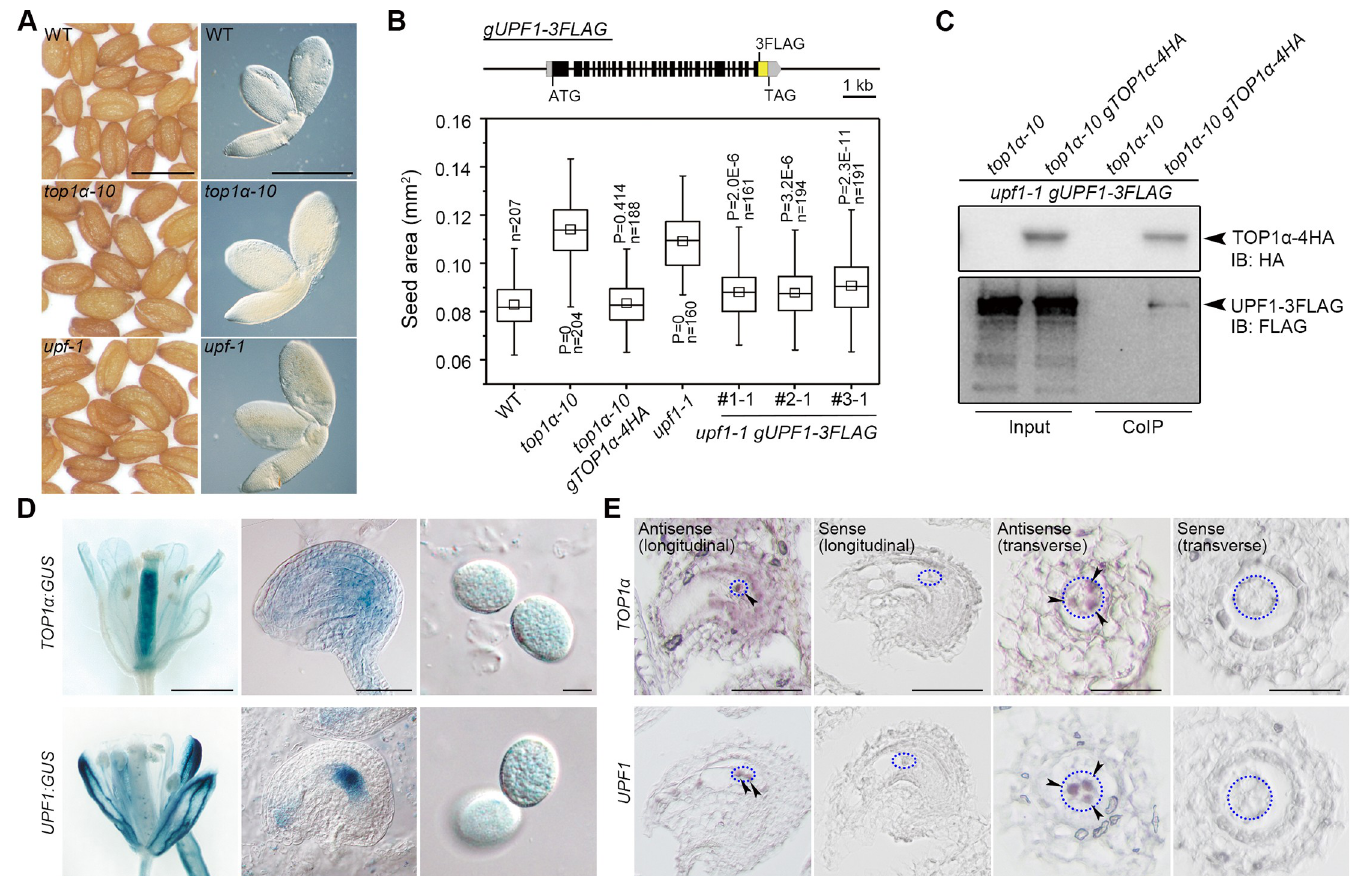
Fig 1. TOP1 α and UPF1 regulate seed size and interact in the nucleus. (A) top1 α -10 and upf1-1 produce larger seeds than WT. Left panels, mature seeds; right panels, mature embryos. Scale bars, 0.5 mm. (B) Seed sizes of top1 α -10 and upf1-1 are rescued by correspondent genomic fragments. Upper panel: schematic diagram of the gUPF1-3FLAG construct. Lower panel: seed sizes of different genetic backgrounds. P values were determined by two-tailed Mann-Whitney U-test compared to WT. (C) In vivo interaction between TOP1 α and UPF1 shown by CoIP. Nuclear protein extracts from pistils of the specified genotypes were immunoprecipitated by anti-HA antibody. The input and CoIP proteins were detected by anti-HA (upper panel) and anti-FLAG antibody (lower panel), respectively. (D) Representative GUS staining of TOP1 α : GUS and UPF1 : GUS in opening flowers (left panels), ovules (middle panels), and pollen grains (right panels). Scale bars, 1 mm, 50 μ m, 10 μ m from left to right. (E) In situ localization of TOP1 α and UPF1 mRNA expression in ovules. Blue dotted ellipses indicate the regions where antipodal cells are located, and arrowheads indicate antipodal cells with signals. Scale bars, 50 μ m, 50 μ m, 25 μ m, and 25 μ m from left to right. The data underlying this figure are included in S1 Data and S1 Raw Images. CoIP, co-immunoprecipitation; GUS, β -glucuronidase; HA, hemagglutinin; n, number of seeds examined; IB, immunoblotting; WT, wild type.